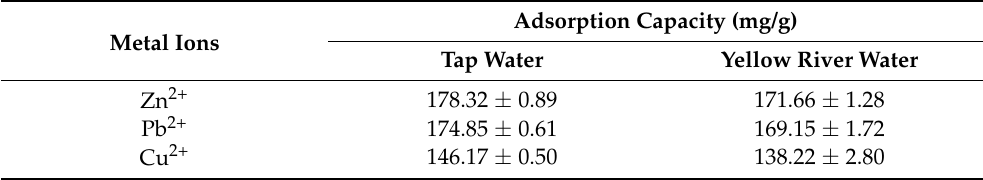
Table 3. The adsorption capacity of Zn 2+ , Pb 2+ , and Cu 2+ in tap water and Yellow River